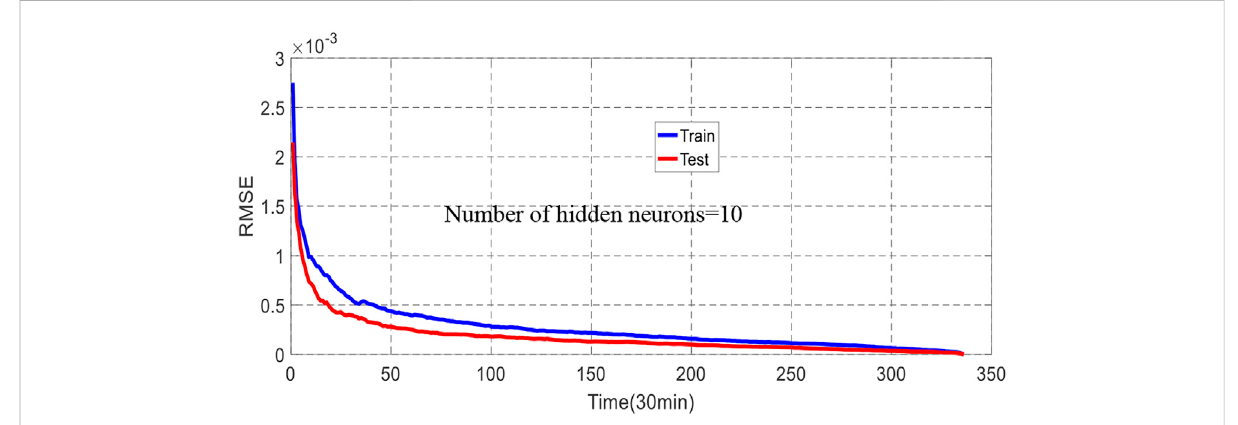
FIGURE 17 RMSE for wind power forecasting using 10 hidden neurons (7 days).